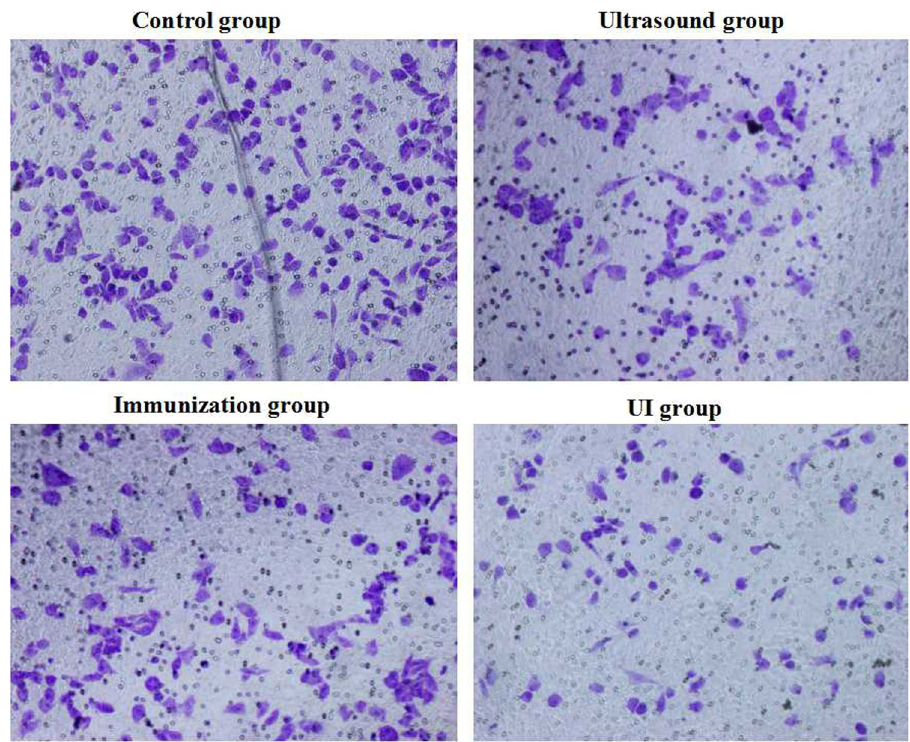
Figure 6. Numerous cells passed through the Matrigel matrix in the control group; fewer cells of the immunization and ultrasound groups invaded; cell invasiveness in the UI group was the weakest ( ×